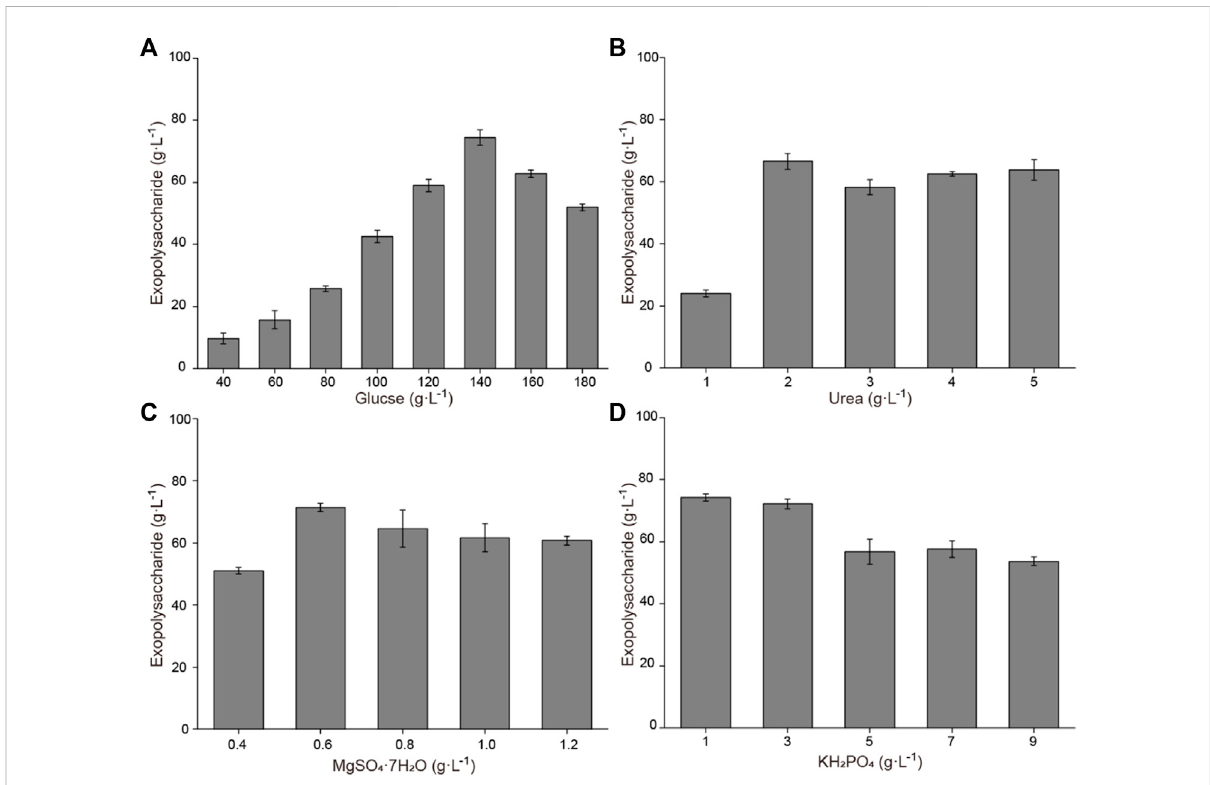
Effects of medium components on exopolysaccharide accumulation in fl asks. (A) Effects of glucose concentration on exopolysaccharide accumulation. (B) Effects of urea concentration on exopolysaccharide accumulation. (C) Effects of MgSO 4 · 7H 2 O concentration